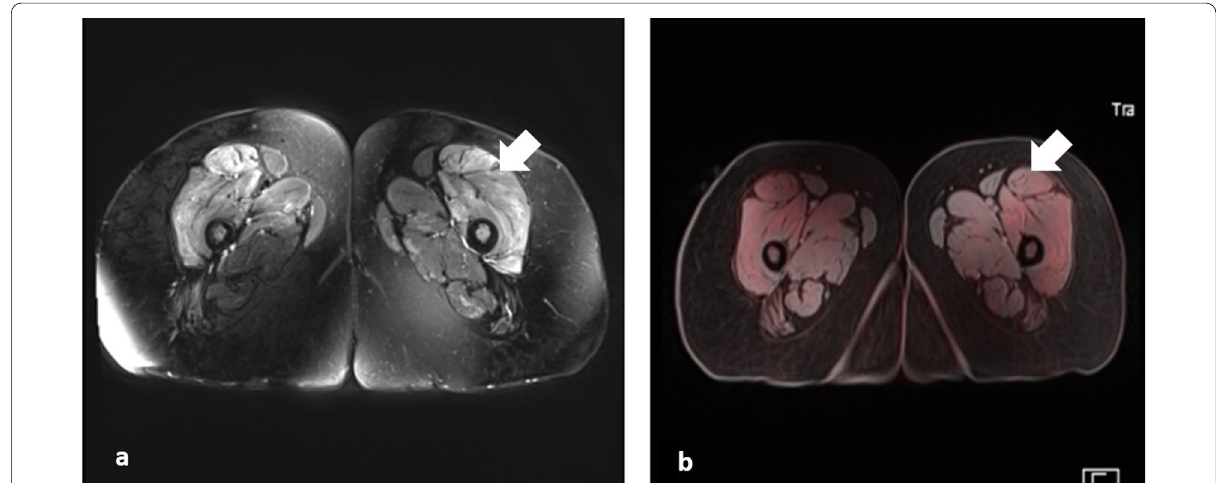
Fig. 5 Axial section of thigh muscle in a 33 year old patient with Dermatomyositis showing increased FDG uptake in anterior compartment thigh muscles with corresponding hyperintensity in T2 Fat Saturation